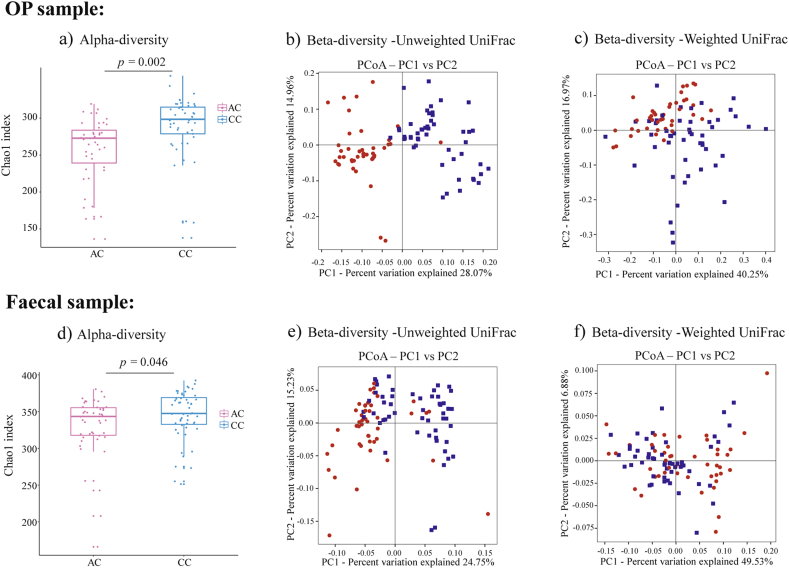
– The alpha and beta diversity of OP and fecal samples from AC and CC children: Alpha diversities are exemplified by the Chao1 index for oropharyngeal (OP) samples in panel a), as well as fecal samples in panel d). The top and bottom lines of box plots showed the interquartile range, and lines inside the boxes represented medians. Beta diversities for OP samples are represented by Principal coordinate analysis (PCoA) plots of b), unweighted and c), weighted UniFrac matrix, whereas those for fecal samples are similarly represented in panels e), unweighted and f), weighted UniFrac matrix. For beta diversity analyses, data points represent either AC samples (red) or CC samples (blue), and the 2 major principle components are respectively represented on the x- and y-axes.